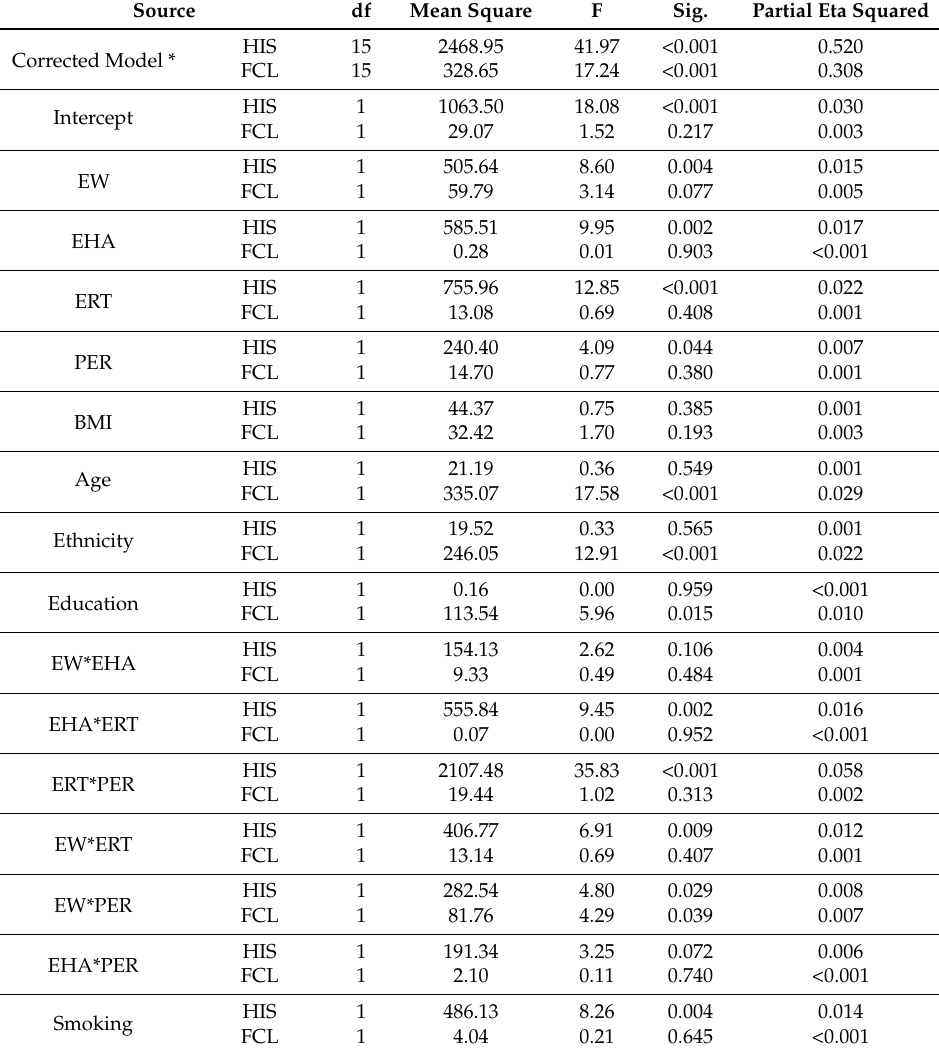
Table 6. Between-variable effects of demographic characteristics and explanatory factors on health outcomes.